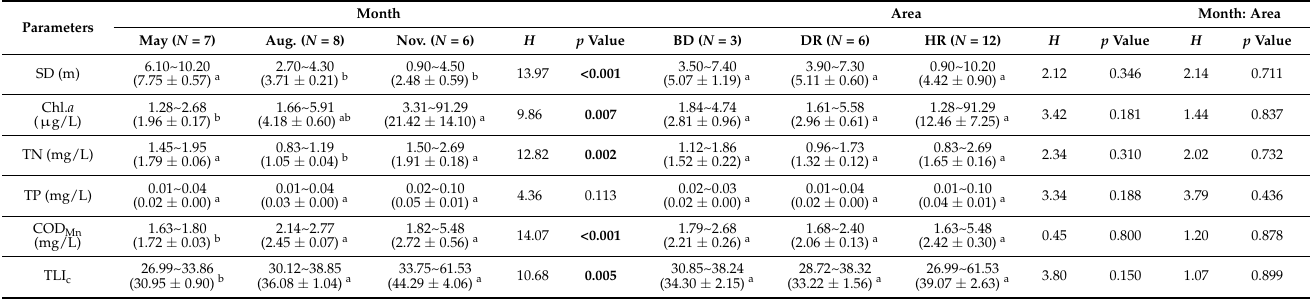
Table 2. Variations in water quality parameters in DJKR with the comparison results between different sampling time and